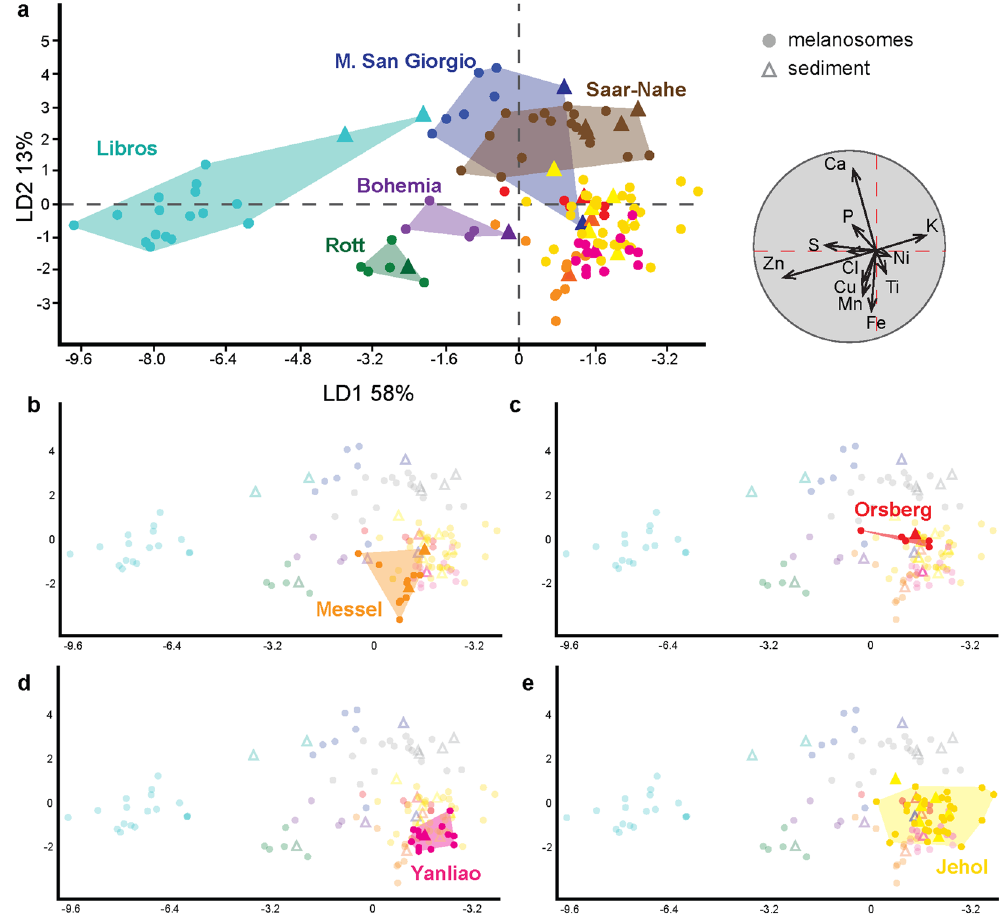
Figure 2. Linear Discriminant Analysis (LDA) of inorganic chemistry data for fossil melanosomes and sedimentary matrices. ( a ) Scatterplot of the LDA chemospace for the entire dataset with biplot (grey circle). Biplots show the most discriminating variables, i.e. those that contribute most to the separation among groups. ( b–e ) Panels highlighting the data for the Messel ( b ), Orsberg ( c ), Yanliao ( d ) and Jehol ( e ) biotas in the LDA plot in ( a